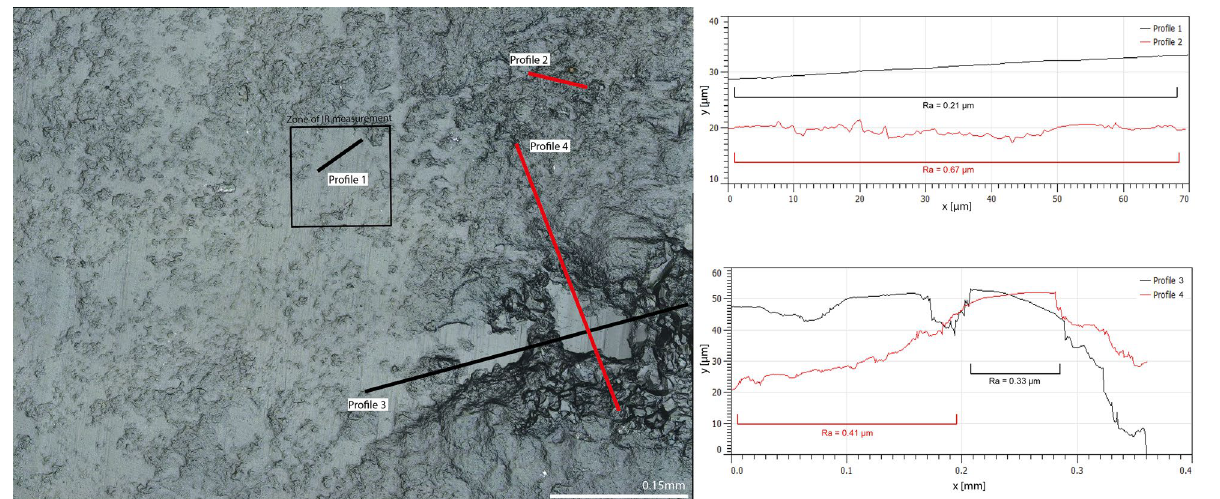
Figure 4. 3D surface model of chert abraded against beech wood and the corresponding extracted profiles. Note the plateau effect created by the abrasion of the higher parts of the surface. Rendered with Gwyddion v. 2.4, http://gwydd ion.net/ 32